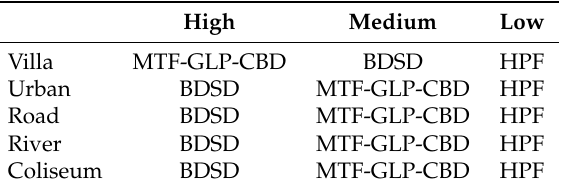
Table 14. Clustering of pan-sharpening algorithms applied to IKONOS Roma Villa, Urban, Road, River, and Coliseum scenes’ data into high, medium, and low performance. Input data for clustering are the reduced resolution scores indexes Q q , Q ERGAS , Q sCC , and Q q 4 in Tables 4–8.